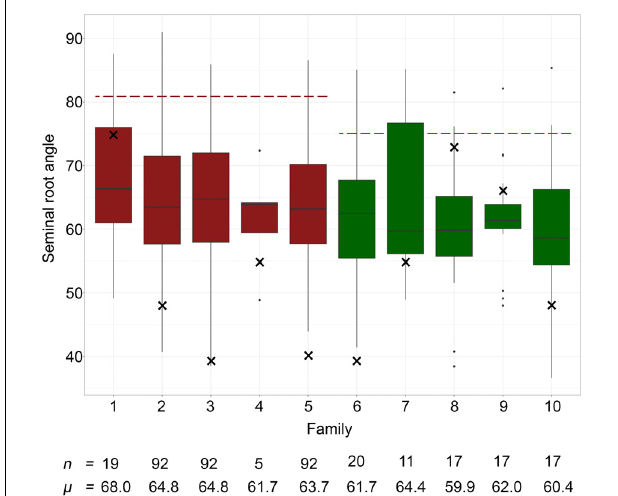
FIGURE 3 | Seminal root growth angle measurements of the 10 NAM families. Families 1 to 5 (red) share DBA Aurora as the common parent, and families 6–10 (green) share Jandaroi as the common parent. Family 1 = DBA Aurora × Fastoz7; Family 2 = DBA Aurora × Outrob4; Family 3 = DBA Aurora × Fastoz8; Family 4 = DBA Aurora × Fadda98; Family 5 = DBA Aurora × Fastoz3, Family 6 = Jandaroi × Fastoz8; Family 7 = Jandaroi × Fastoz10; Family 8 = Jandaroi × Fastoz6; Family 9 = Jandaroi × Fastoz2; Family 10 = Jandaroi × Outrob4. Boxplots display the quartile range and median SRA (horizontal line) of individuals within each of the 10 sub-NAM populations. The broken red line displays the mean SRA value of DBA Aurora and the broken green line displays the mean SRA value of Jandaroi; × represents the mean SRA value of ICARDA founder lines; n represents the number of individuals in each family; µ represents the mean SRA value of each